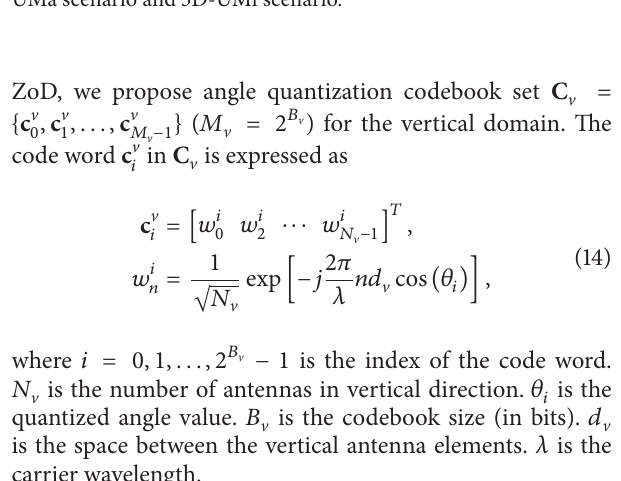
Figure 6: The CDF of users’ ZoD in the cellular network under 3D- UMa scenario and 3D-UMi